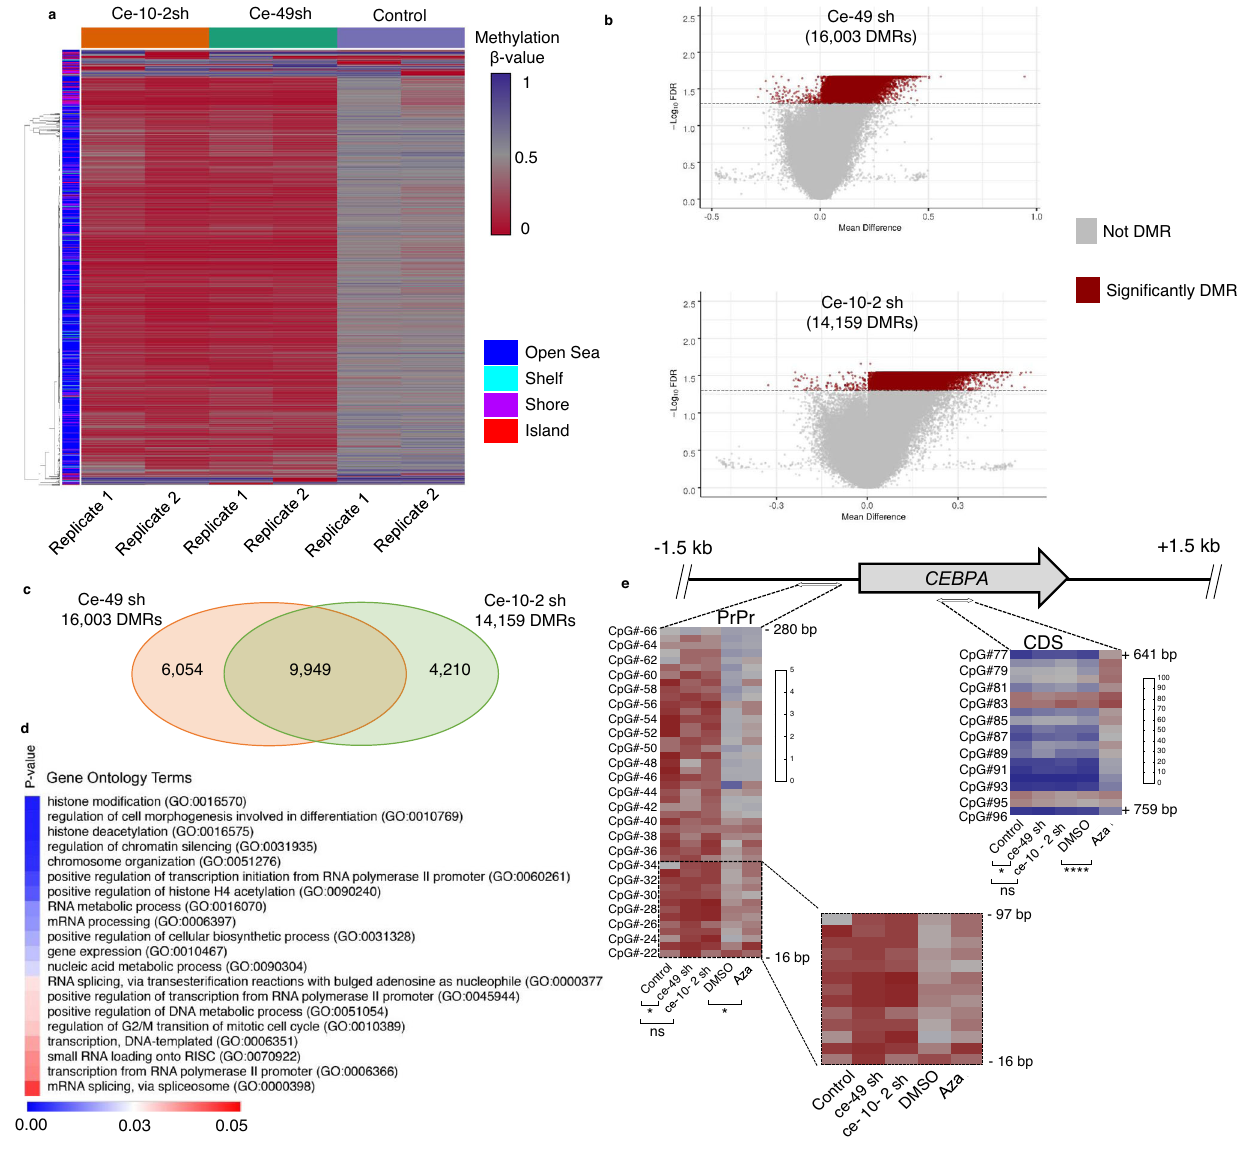
Fig. 6 | DNA methylation analyses. a Heatmap of differentially methylated CpG regions (DMR) in K562 transfected with Ce-49 sh, Ce-10-2 sh or control (Cont.) aptamers. b Volcano plots reporting the signi fi cantly DMRs for Ce-49 sh ( upper panel )andCe-10-2sh( lowerpanel ). c DMRsoverlappingbetweenCe-49shandCe- 10-2sh. d HeatmapoftoprankedGeneontologytermsforgenescorrespondingto